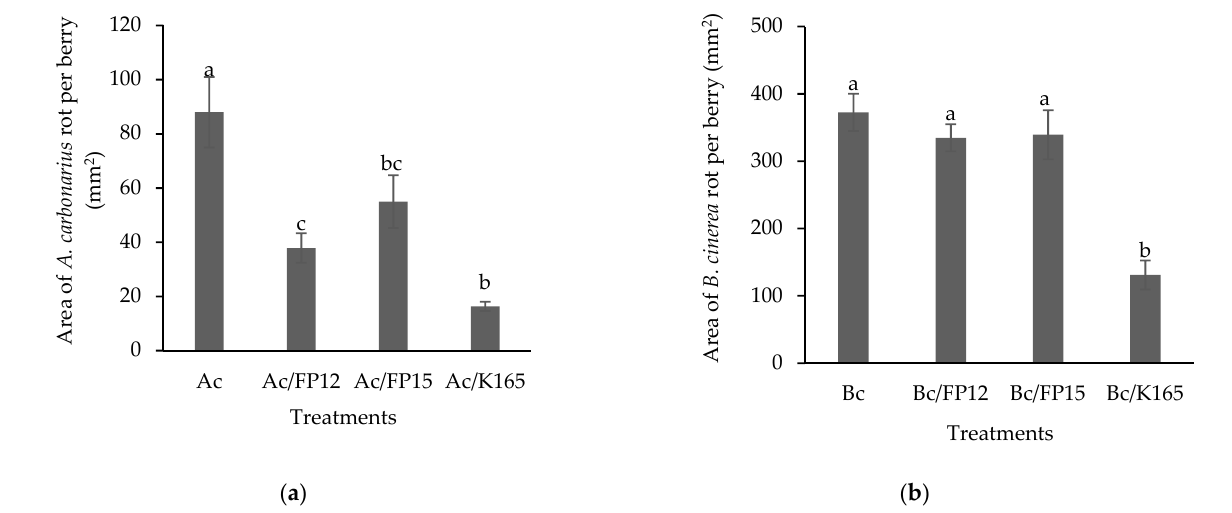
Figure 2. Area of Aspergillus carbonarius , Ac, ( a ) and Botrytis cinerea , Bc, ( b ) rot on grapes inoculated with K165, FP12 and FP15, at 7 days after pathogen inoculation. The columns represent the means of three biological repeats with eight berries per treatment and repeated experiments ( n = 24). Columns with different letters are significantly different from each other, according to Nemenyi ( a ) and Tukey ( b ) multiple range tests ( p < 0.05). The vertical bars indicate the values of the standard error.